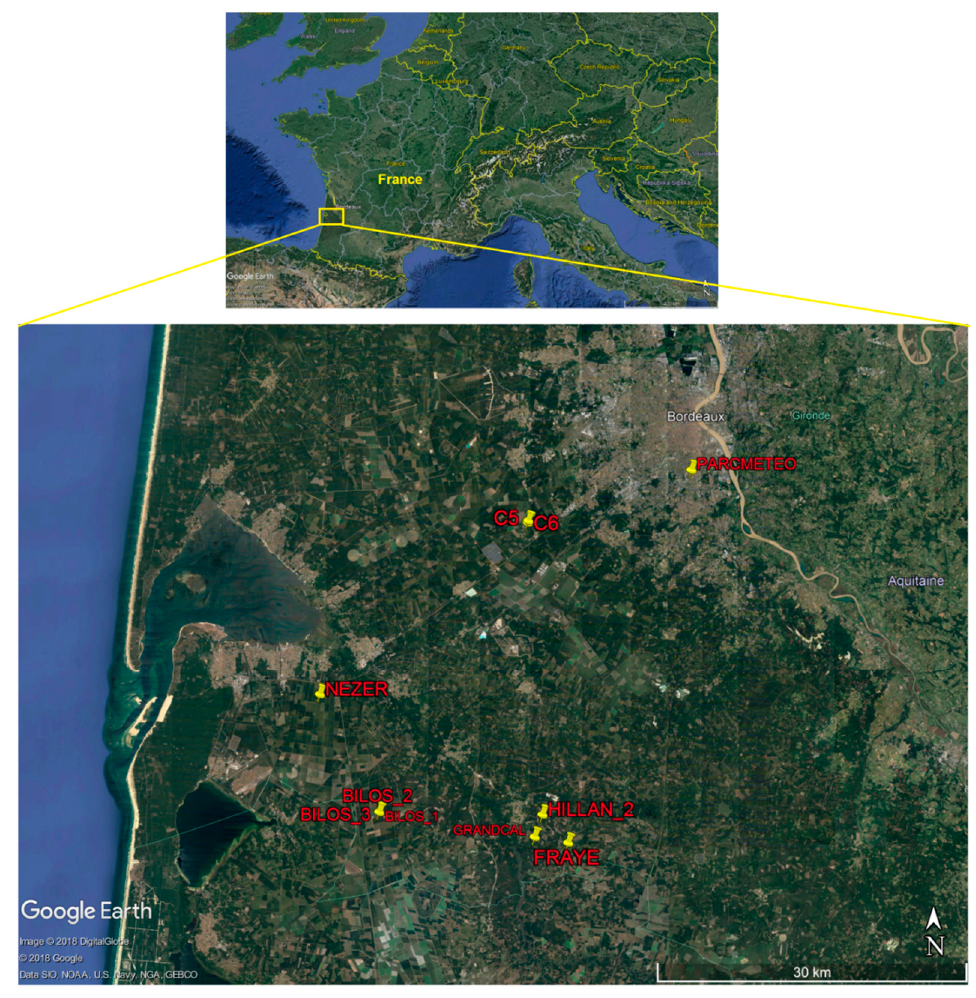
Figure 1. The AQUI network in South-Western France ( top panel ). Distribution of the AQUI network stations in the Aquitaine region in France ( bottom panel ).